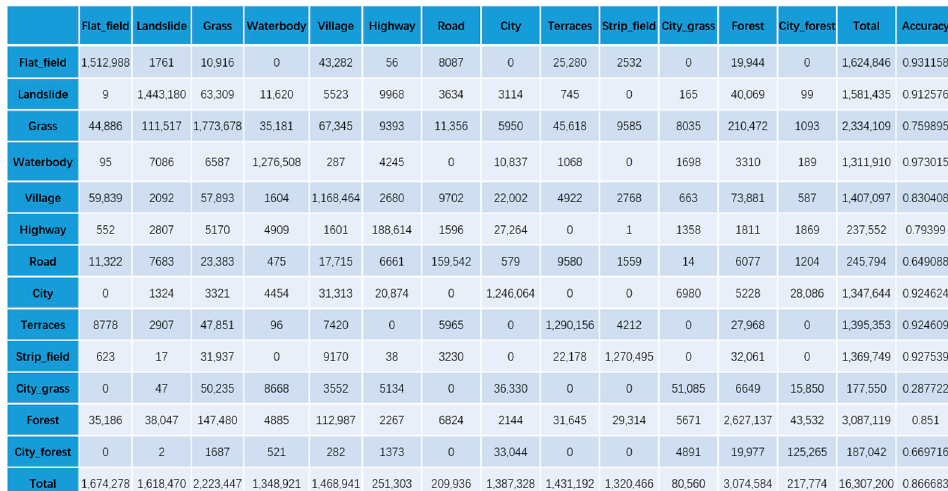
Figure 16. The pixel-based confusion matrix of the U-Net model.